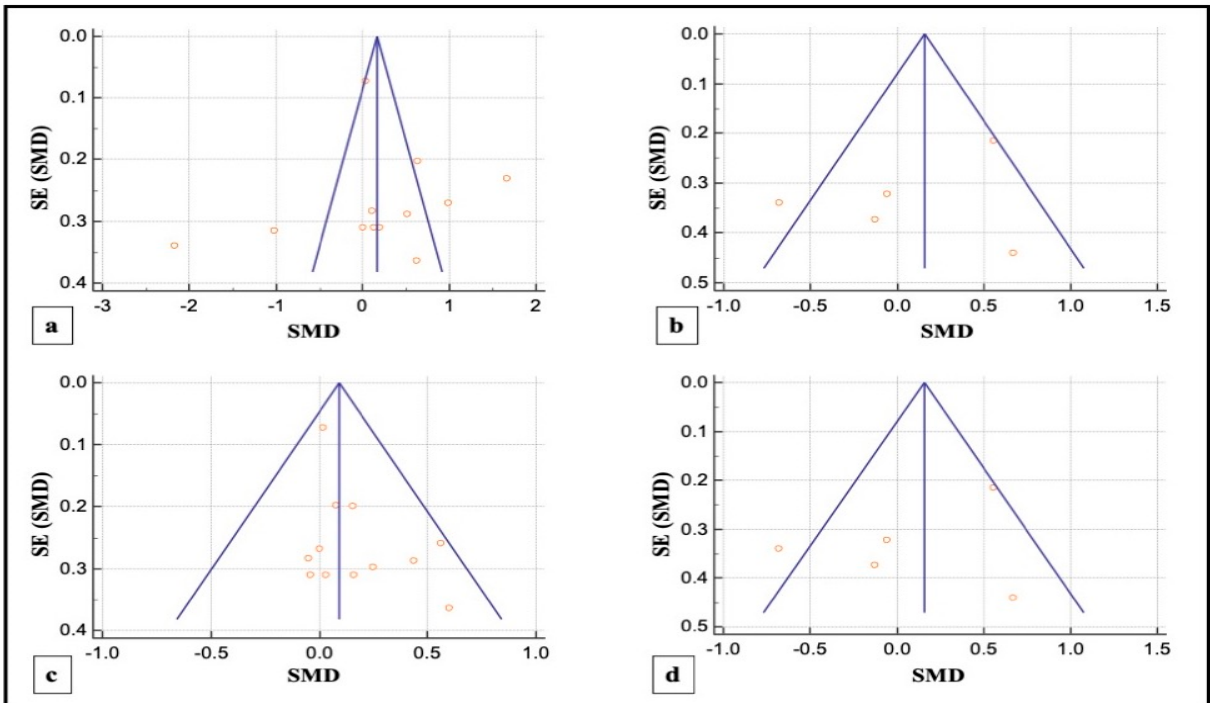
Figure 6. ( a , b ) Funnel plots illustrating the publication bias in overall PPD reduction in SM and PG studies, respectively; ( c , d ) funnel plots illustrating the publication bias in overall CAL gain in SM and PG studies, respectively. Each circle represents a single included study, the y-axis and x-axis represent the standard error of the effect estimate and the results of the study respectively and the graphical plot resembles an inverted funnel with scatter due to sampling variations.